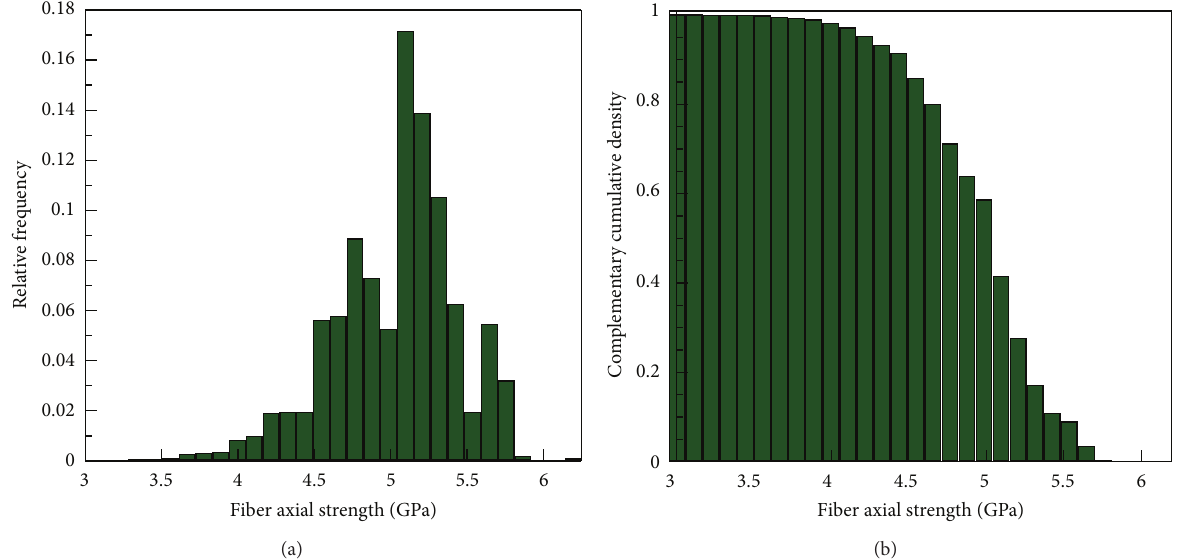
Figure 8: (a) Longitudinal-tensile-strength relative frequency (i.e., probability density function); and (b) the corresponding complementary cumulative density function for defective virgin